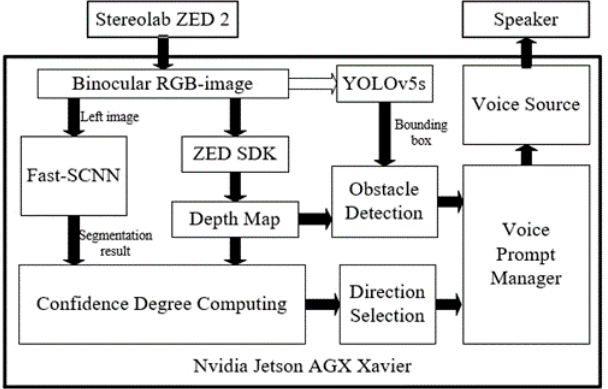
Figure 2. The software structure of the assistive system.